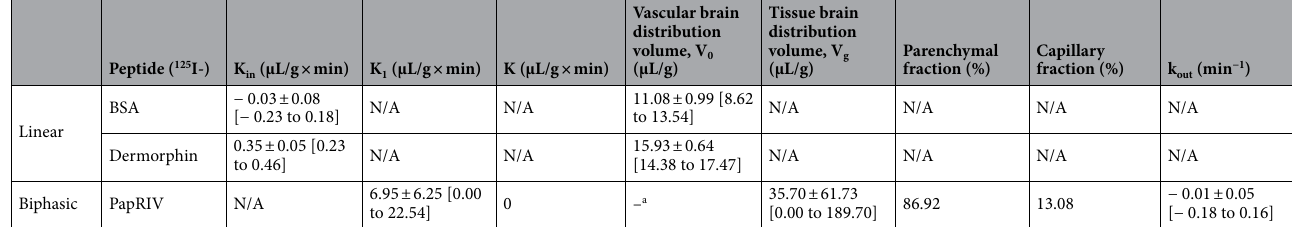
Table 2. Overview of the multiple time regression results of BSA, Dermorphin and PapRIV using both the linear- and biphasic model (mean ± standard error, 95% CI interval between brackets). N/A not applicable seen the model applied. a (V 0 ): The vascular brain distribution volume V 0 was set to be equal to the V 0 of radio- iodinated BSA obtained in these experiments (11.077 µL/g) (= V i